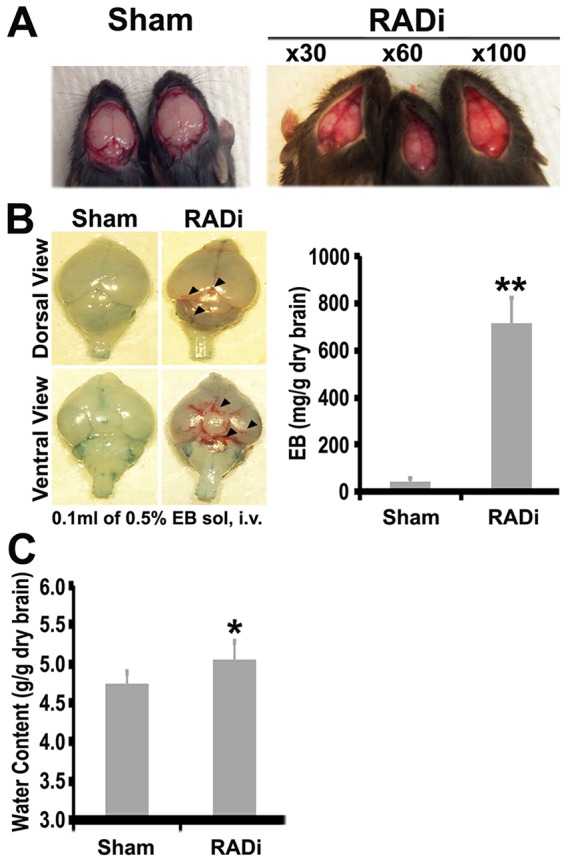
Hemorrhage and cerebral edema following RADi. (A) Subdural/subarachnoid hemorrhages of brains of sham mice (left) and mice following different repetitions of RADi at 60 psi (right). (B) Breakdown of BBB integrity owing to increased vascular permeability in sham mice and in mice subjected to 60 psi×60 RADi taken 7 h postinjury. The dramatic retention of Evans Blue in traumatized brains compared with that in sham brains indicates increased permeability of the BBB. (C) Water content in sham and RADi mice. Data are presented as mean±s.d. and were analyzed by unpaired two-tailed Student's t-test. *P<0.05, **P<0.01; n=5 per group. Arrowheads indicate subarachnoid hemorrhage.